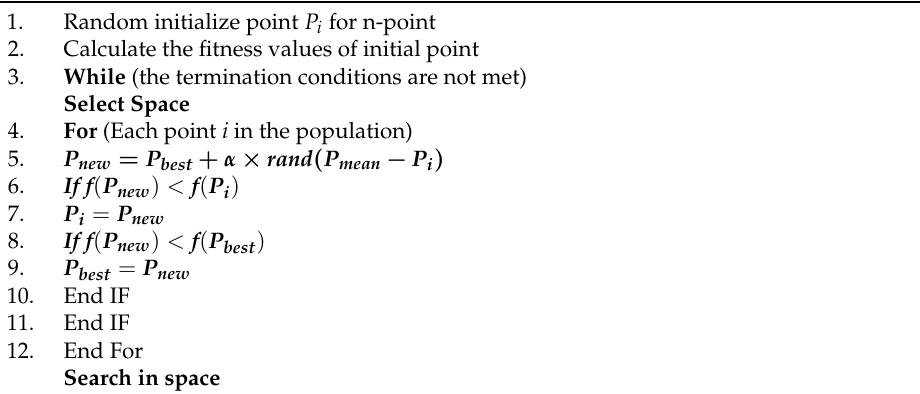
Figure 5. Flowchart of the proposed method. Table 3. The pseudocode of the bald eagle search optimization algorithm